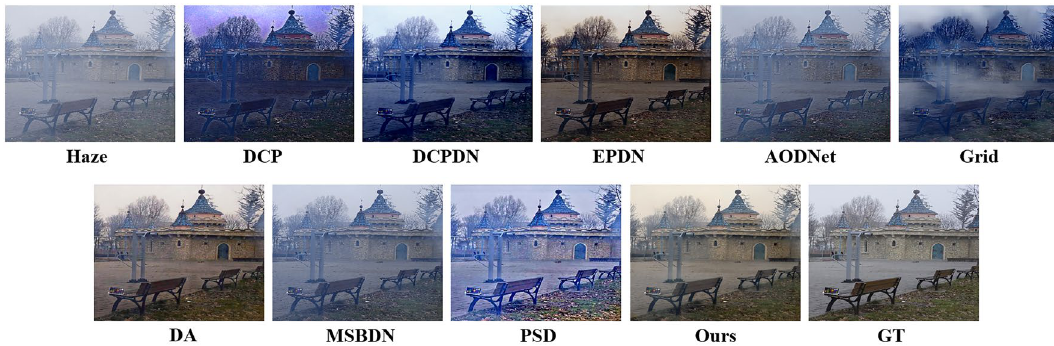
Figure 7. Results of comparison experiments on the O-HAZE.